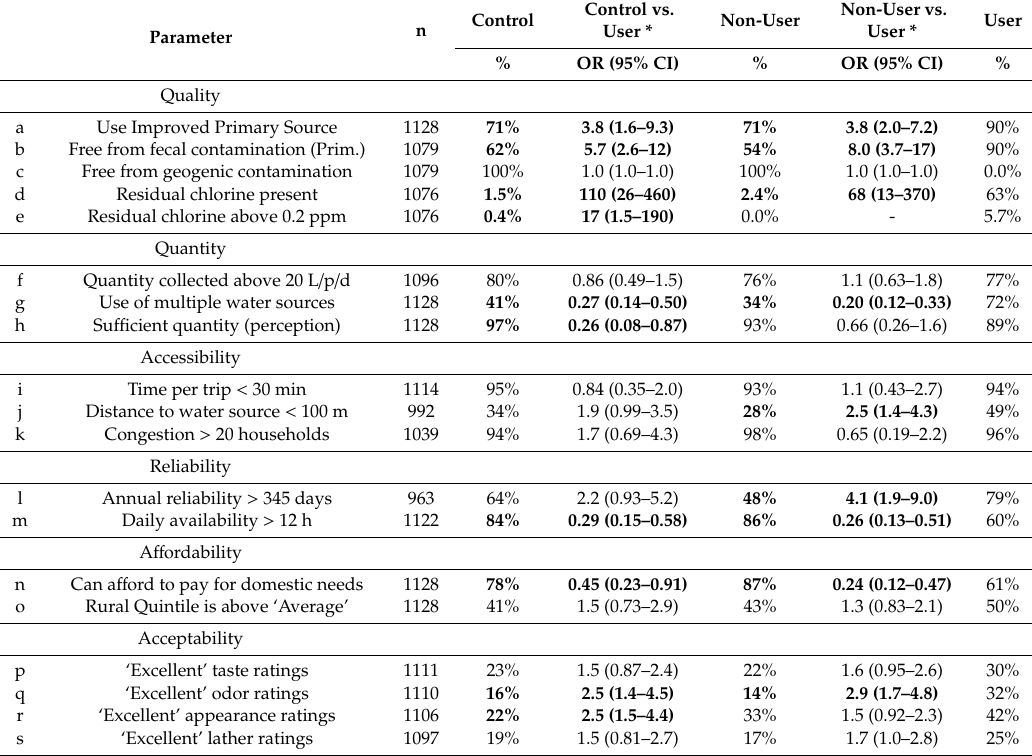
Figure 3. Household service level scores by ( a ) Control and intervention (User vs. Non-User) groups and ( b ) primary source management groups. Table 4. Multinomial logistic regression for service level indicators by household group.